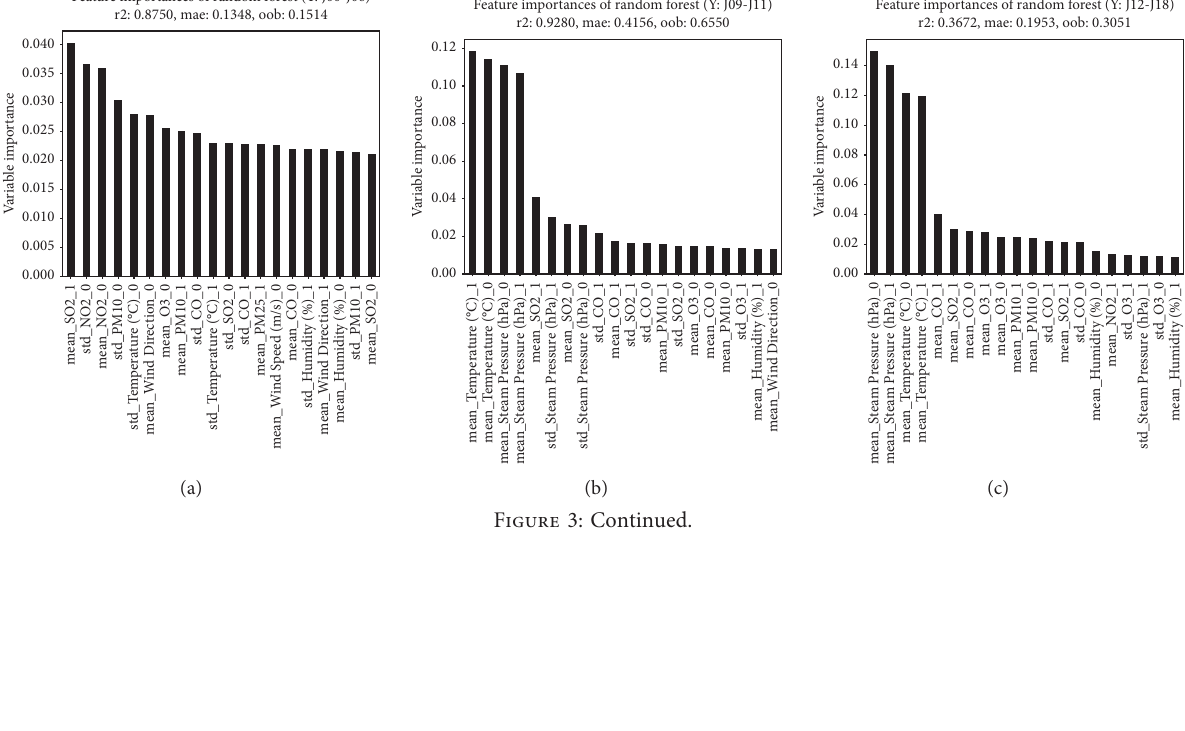
Feature importances of random forest (Y: J00-J06) r2: 0.8750, mae: 0.1348, oob: